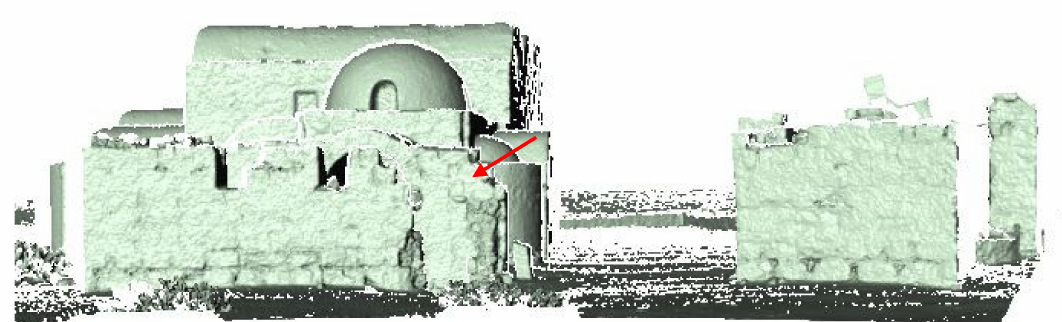
Figure 14. Three-dimensional meshed model of Qusayr ‘Amra façade using TLS.